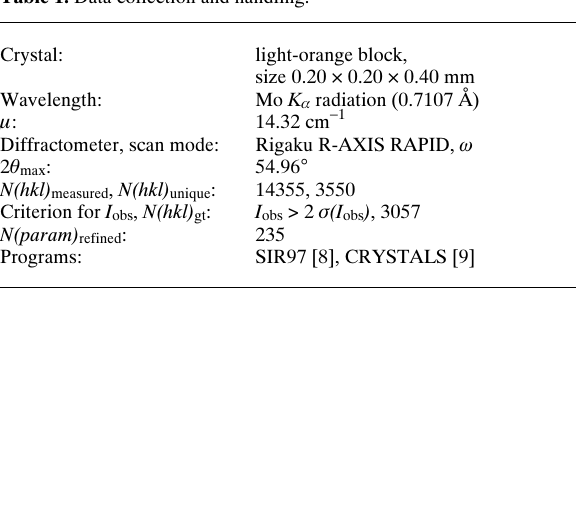
Table 2. Atomic coordinates and displacement parameters (in Å 2 ) . Table 1. Data collection and